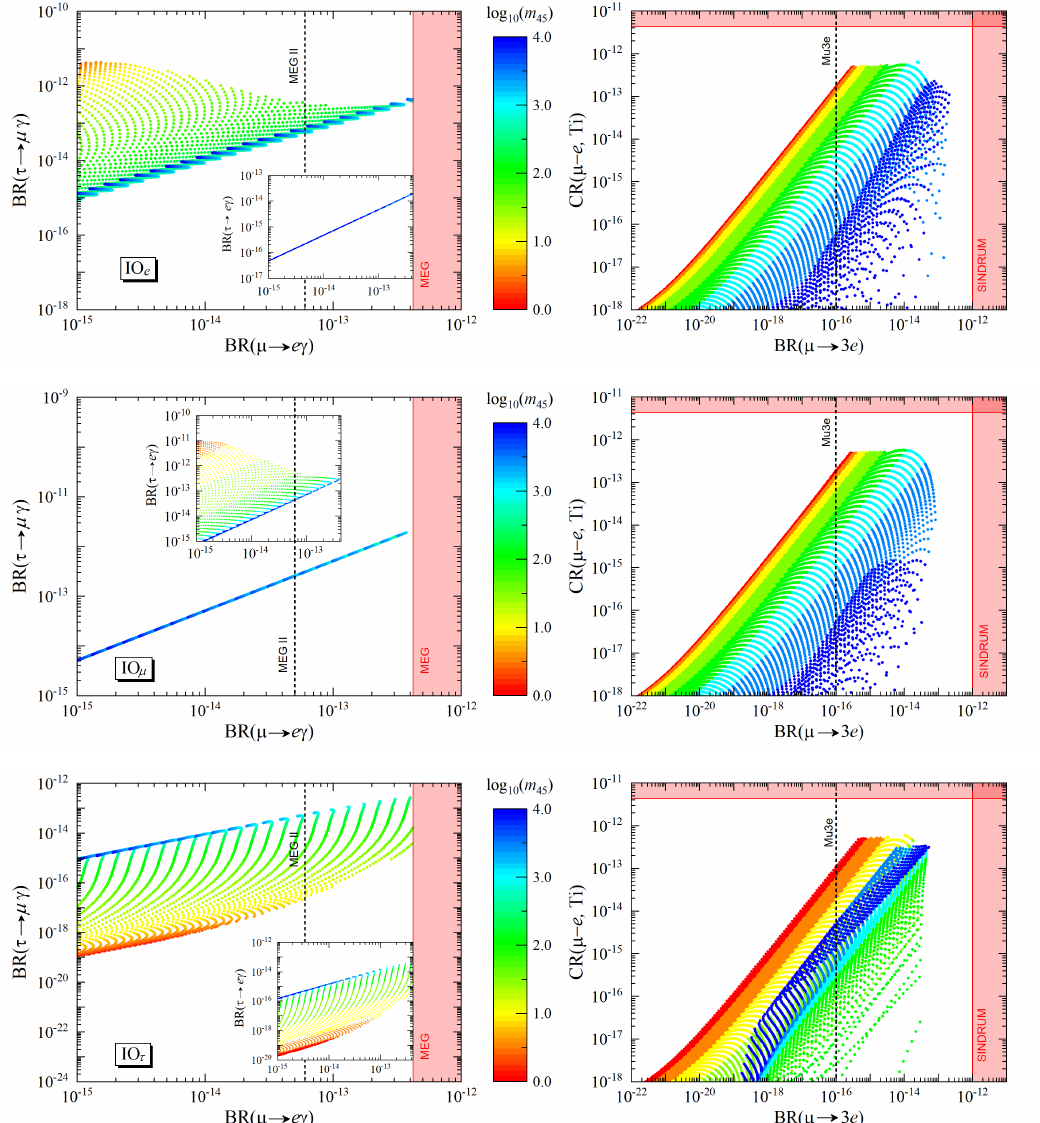
Figure 7 . The same as in figure 6 for IO e , IO µ and IO τ